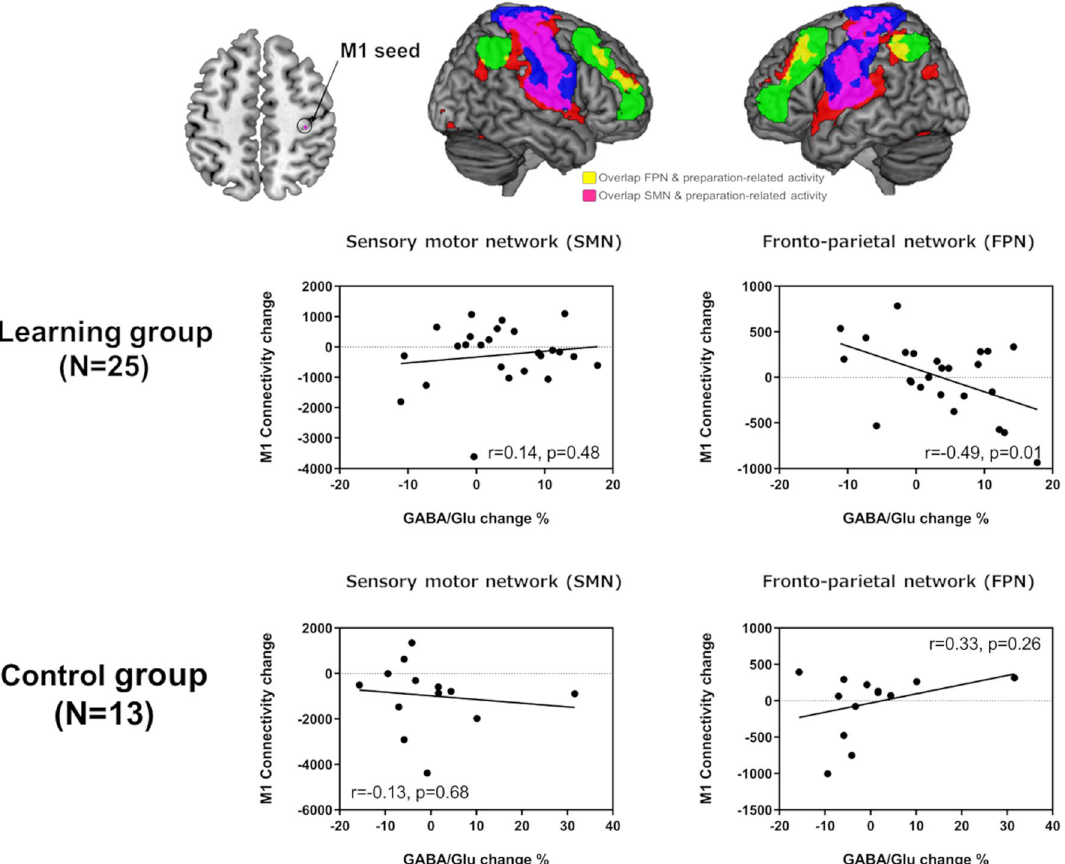
Figure 6. Region of interest (ROI)-based analysis of functional connectivity between the right primary motor cortex (M1) and sensorimotor network (SMN), and fronto-parietal network (FPN). (Top Left) M1 seed ROI depicted by the linear increments in preparation-related activity of the Learning Group. The level of statistical significance is set at p < 0.05, family-wise error corrected for multiple comparisons at the voxel-level. (Top Right) ROI overlap of SMN (blue) and FPN (green) with the learning-related network, depicted by the linear increments in preparation-related activity using task functional magnetic resonance imaging (red). SMN and FPN are defined based on the CONN toolbox. (Middle) Relationships between Glu/GABA changes within the right M1 and M1 seed-based resting-state functional connectivity changes in the SMN (Middle left) and FPN (Middle right) after motor sequence learning of the Learning and Control Groups (Bottom). M1 seed-based resting-state functional connectivity changes were calculated using the sum of changes in the connectivity values between the pre- and post-task periods in the